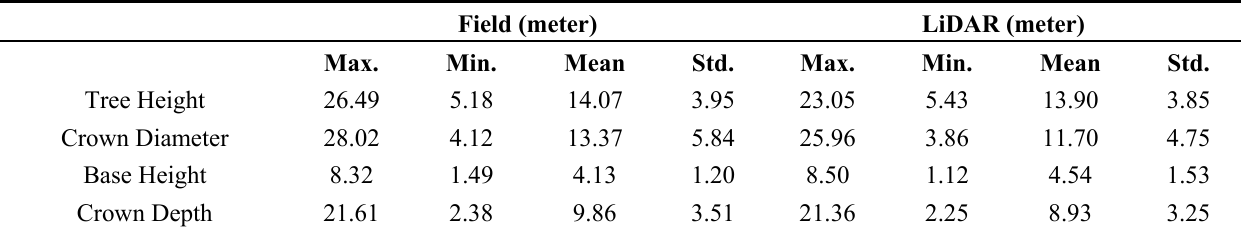
Table 3. Statistics for regressions of field-measured and LiDAR-estimated tree height, crown diameter, base height, and crown depth with and without outliers. With Outliers Without Outliers R 2 RMSE (meter) R 2 RMSE (meter) Tree Height 0.93 1.11 0.98 0.57 Crown Diameter 0.70 2.58 1.90 Base Height 0.63 1.79 Crown Depth 0.71